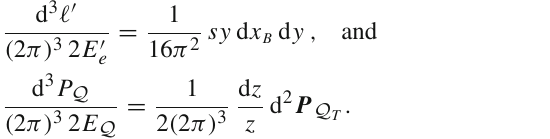
figuration. The relevant CO LDMEs are (cid:2) 0 | O J /ψ ( 3 P ) | 0 (cid:3) , with J = 0 , 1 , 2. The CS produc- and (cid:2) 0 | O J J 8 tion mechanism is possible only at O (α 2 is formed at short distances in a 3 S